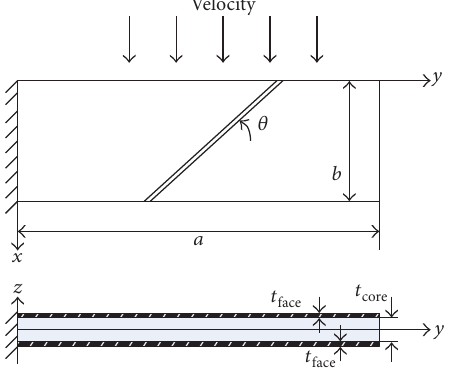
Figure 1: Cantilevered sandwich panel.